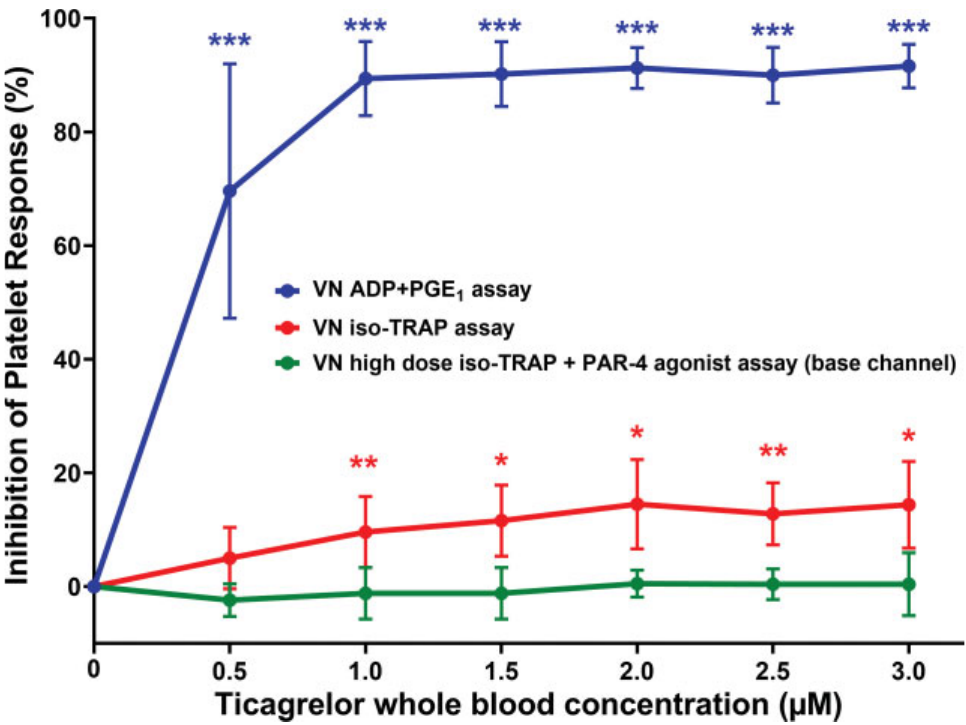
Fig. 5 Effect of in vitro addition of ticagrelor on the VN iso-TRAP, ADP þ PGE 1 , and base channel assays, n ¼ 5, 34 measurements, data are mean (cid:4) SD. All experiments were performed with citrate-anticoagulated blood from healthy donors who were not taking aspirin. (cid:6) p < 0.05 compared with control, (cid:6)(cid:6) p < 0.01 compared with control, (cid:6)(cid:6)(cid:6) p < 0.001 compared with control. VN ¼ VerifyNow. PAR-4 AP ¼ PAR-4 activating